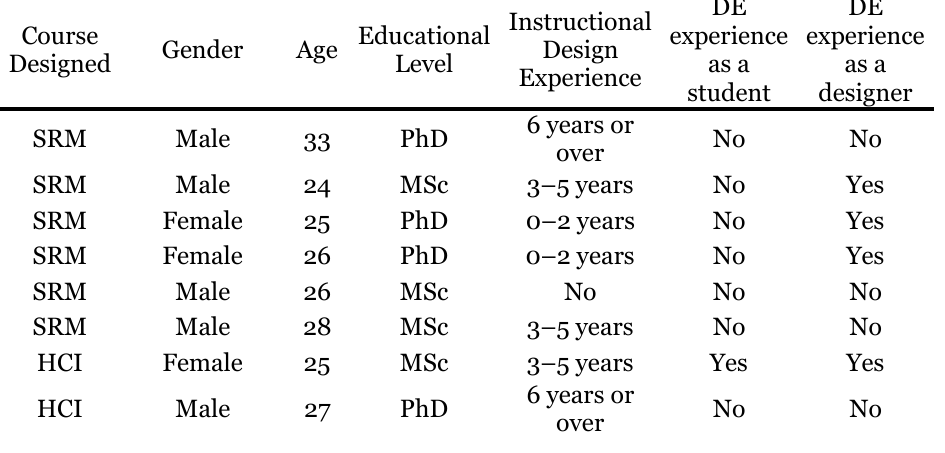
Demographic Characteristics of the Designers and Information Regarding their DE Experiences